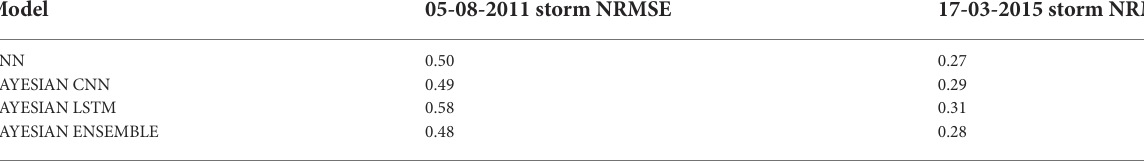
TABLE 1 Normalizedrootmeansquarederror(NRMSE)foreachoftheunitmodels,andthebayesianensemblemodel. Model